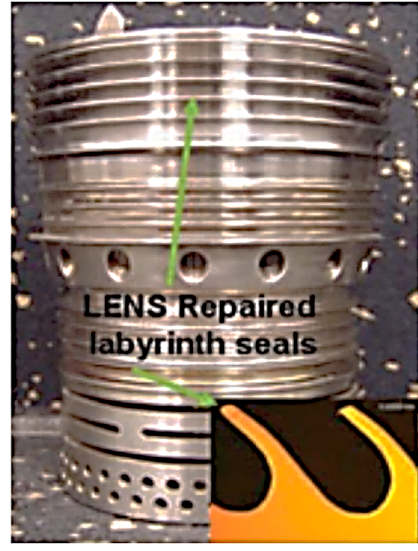
Figure 13. Gas turbine Inconel ® 718 compressor seal repaired by DED process [87].